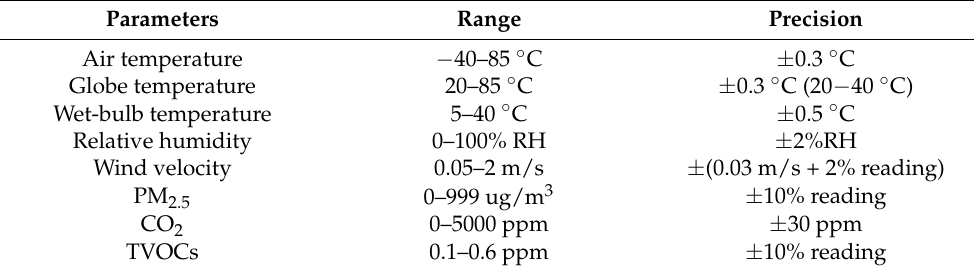
Table 1. Specifications of JT integrated monitor of thermal environment and air quality. Parameters